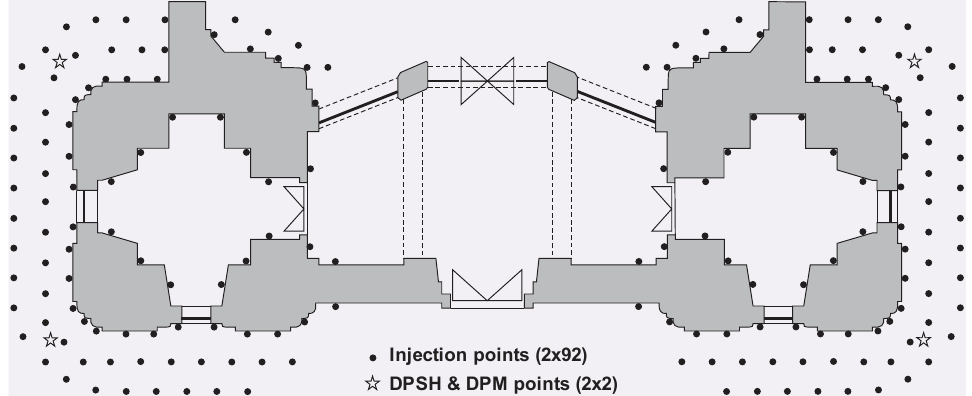
Figure 23. Position of injection points around the foundations of the towers .